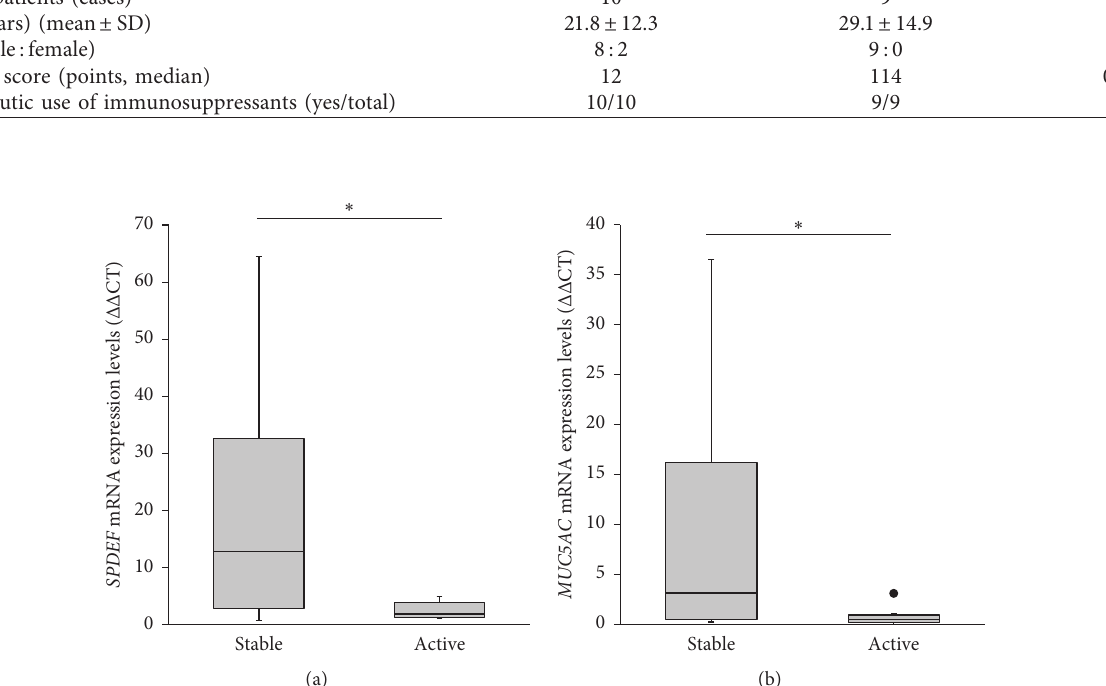
Figure 1: Messenger RNA expression levels of SPDEF and MUC5AC in stable and active groups. Expression levels of SPDEF (a) and MUC5AC (b) mRNA in the active group were significantly higher than those in the stable group. Data are presented as box-whisker plots. Significant differences are indicated as ∗ p < 0 . 05.